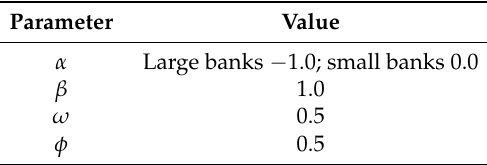
Table 5. Summary of